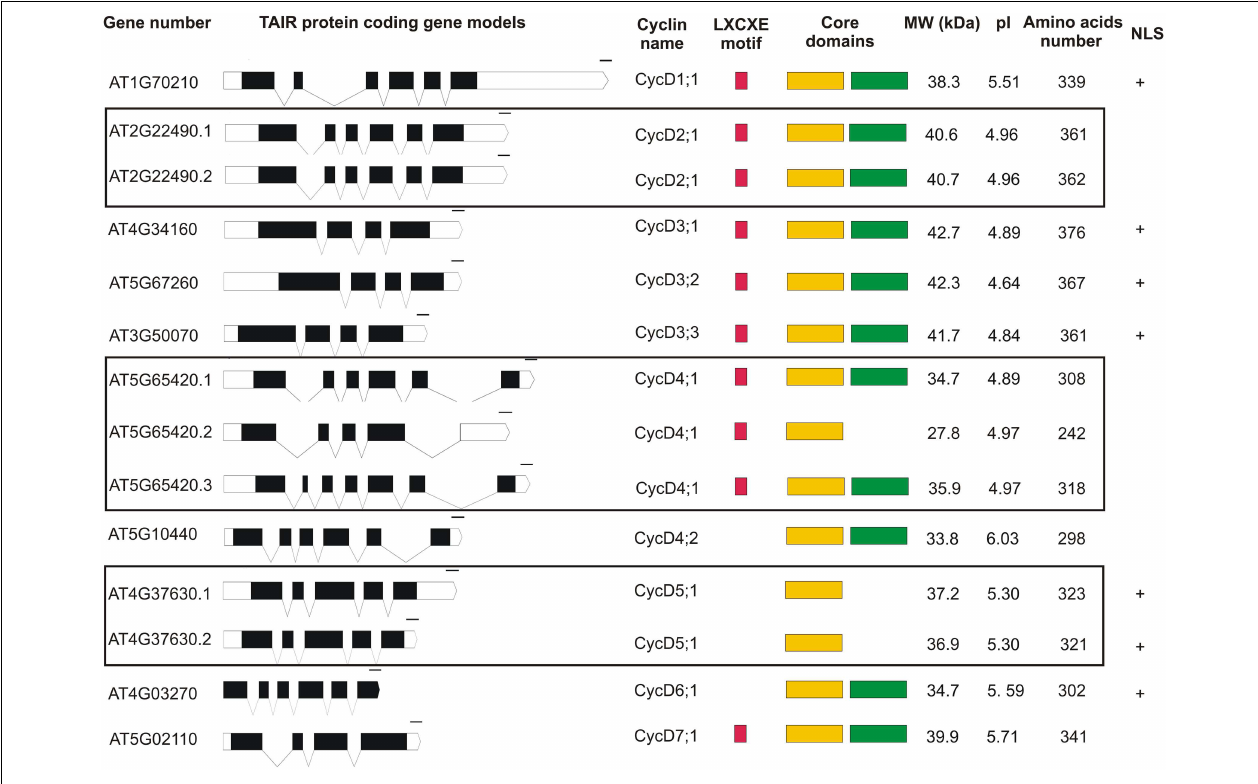
introns. The red, yellow and green colors represent the retinoblastoma protein binding motif (LXCXE), cyclin N- and C-terminal domain respectively. (+) represents the presence of the putative importin- α nuclear localization